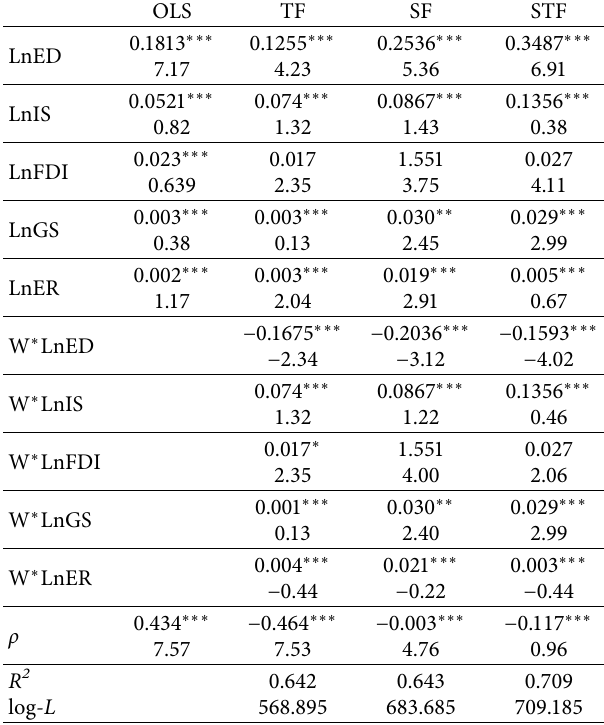
Table 8: Estimation and test results based on spatial Durbin model (SDM) for the driving